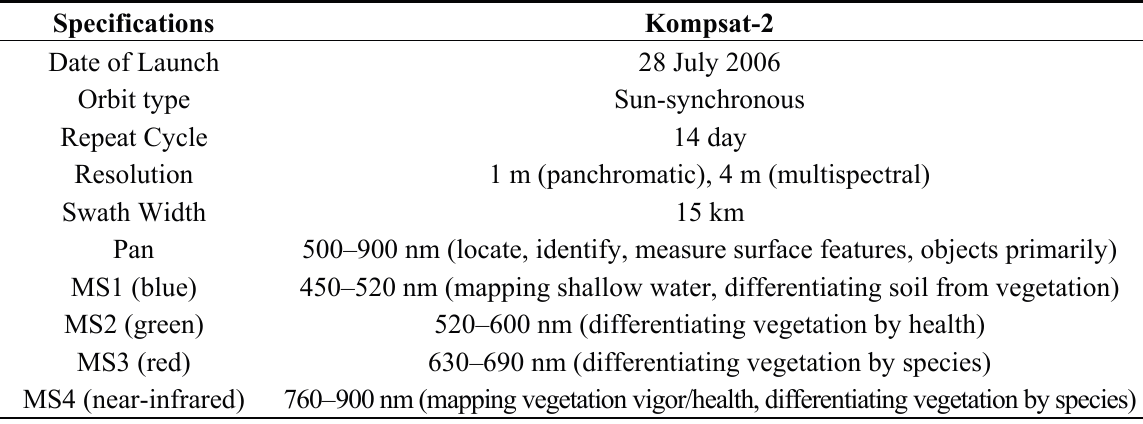
Table 1. Kompsat-2 specifications and primary